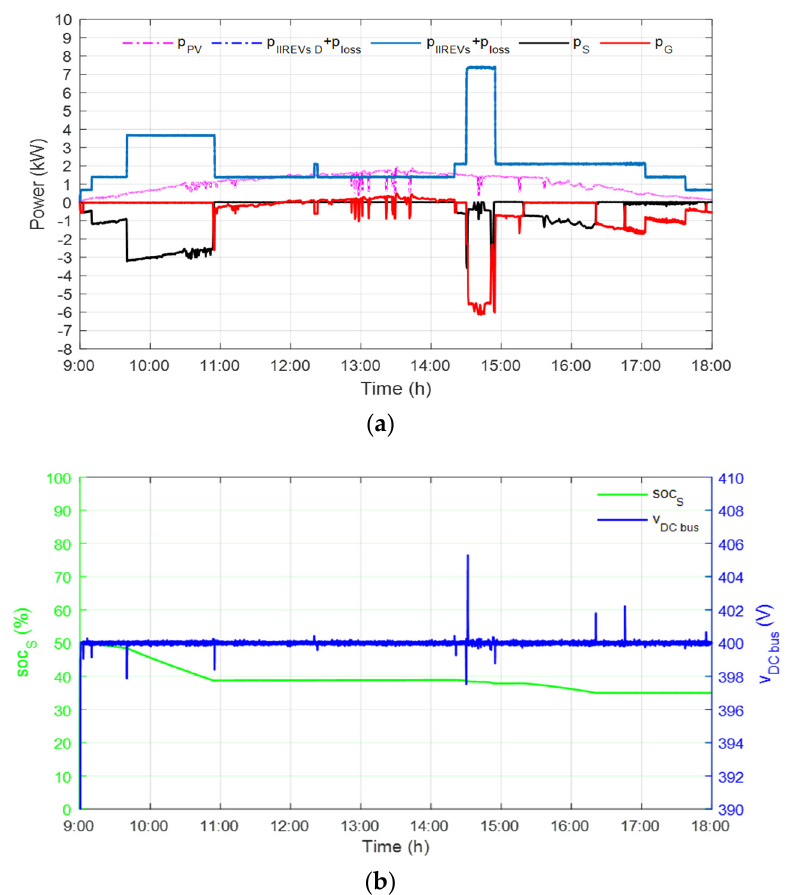
Figure 25. Power flow and storage state of charge for “real-time exp” with optimization ( a ) and ( b ) the storage state of charge and DC bus voltage—experimental test 2b.